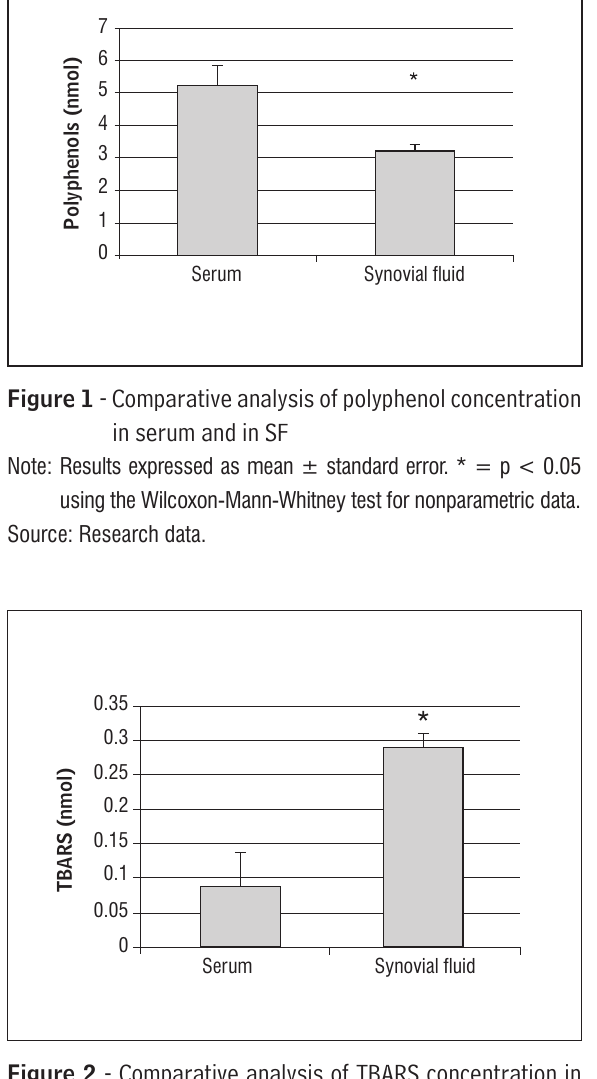
Figure 2 - Comparative analysis of TBARS concentration in serum and in